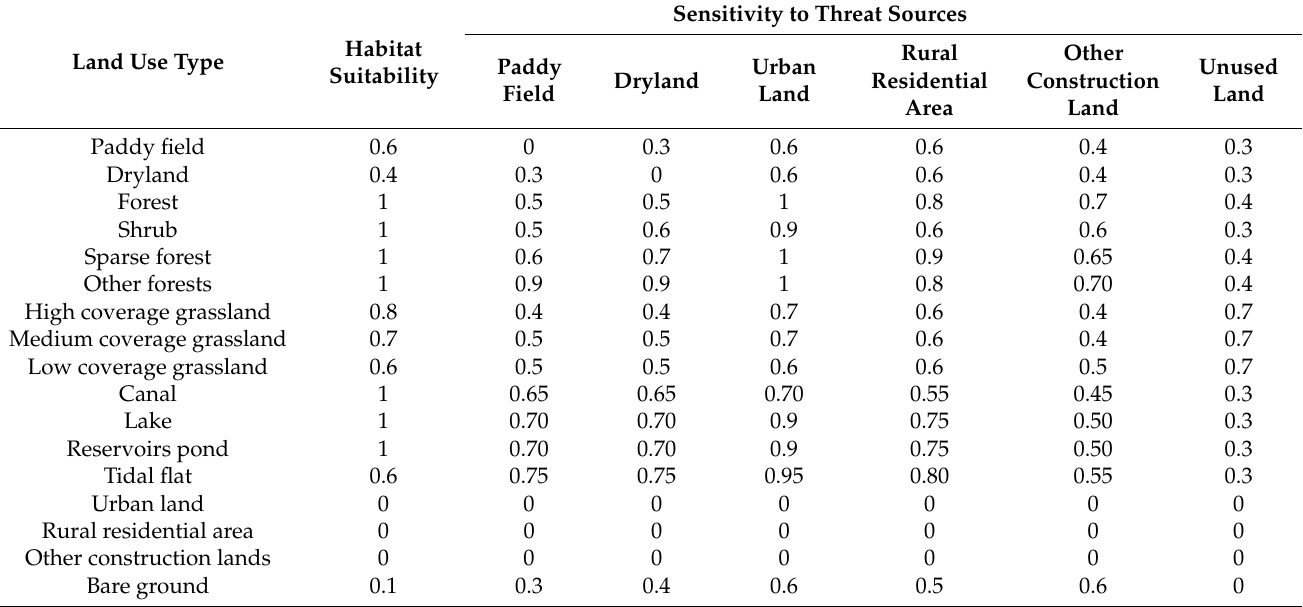
Table 2. Sensitivity parameters of land use types to threat